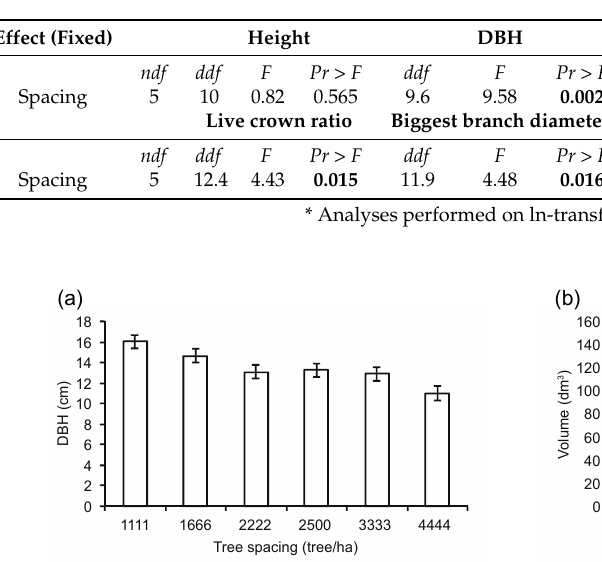
Table 2. Analysis of variance (ANOVA) results for jack pine height, diameter at breast height (DBH, 1.3 m), stem volume and taper, live crown ratio, largest branch diameter, and longest branch, 25 years